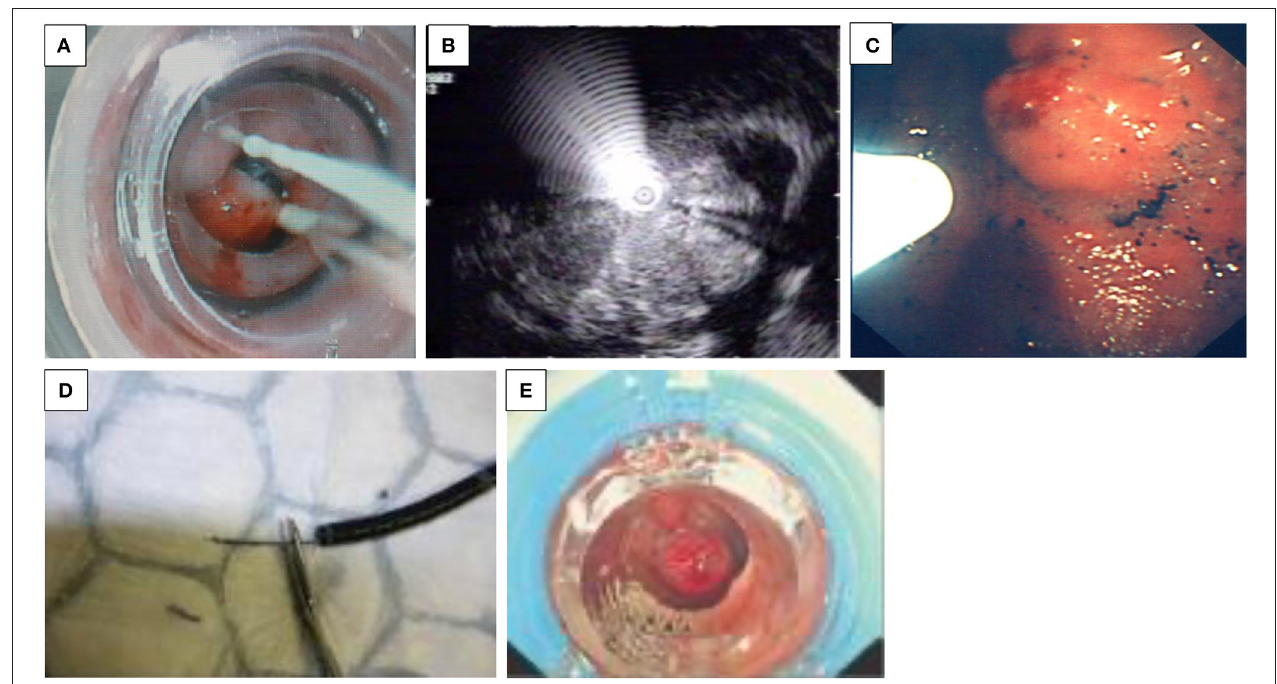
FIGURE 1 | (A–E) Endoscopic treatment of variceal bleeding. (A) Banding of esophageal varices. (B) Echo-endoscopic vision of needle injection of an esophageal varix. (C) Injection of glue into a fundal varix. (D) An inadvertent introduction of glue into the biopsy channel is prevented by cutting the catheter tip off. (E) Banding of jejunal